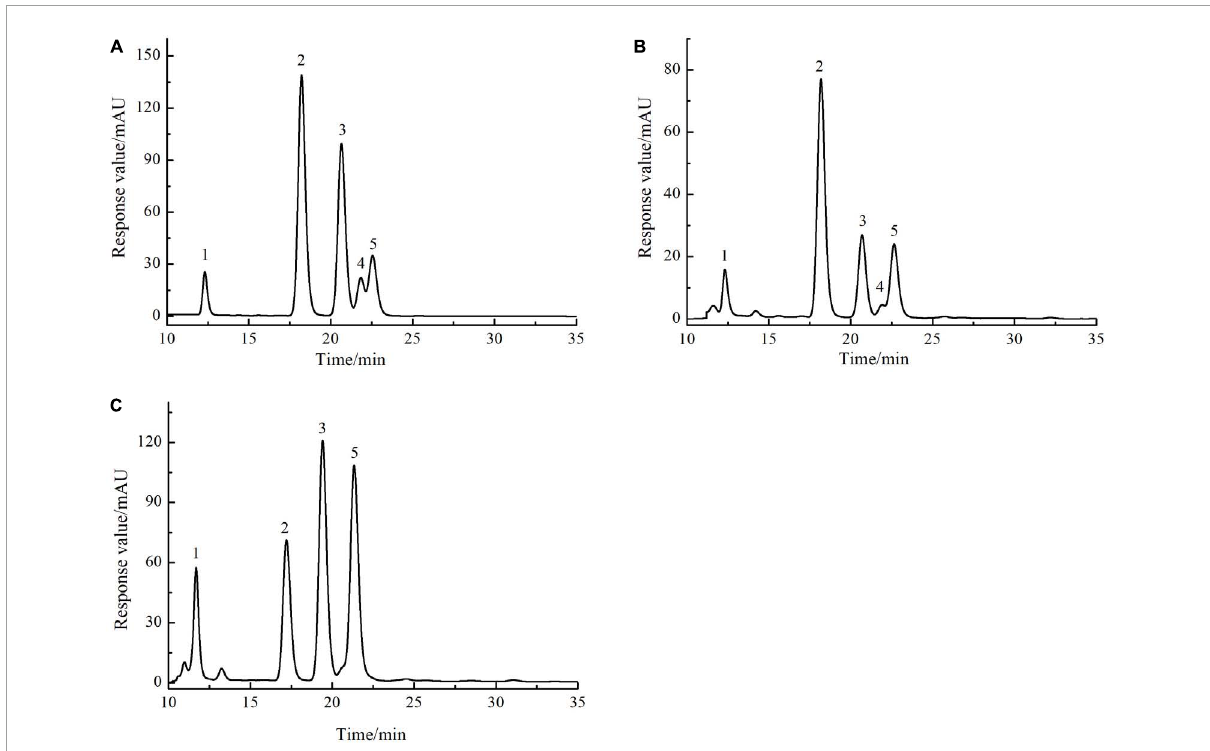
FIGURE4 The HPLC chromatogram of monosaccharides of reference substances solution (A) , SLMPs-1-1 (B) , and SLMPs-2-1 (C)